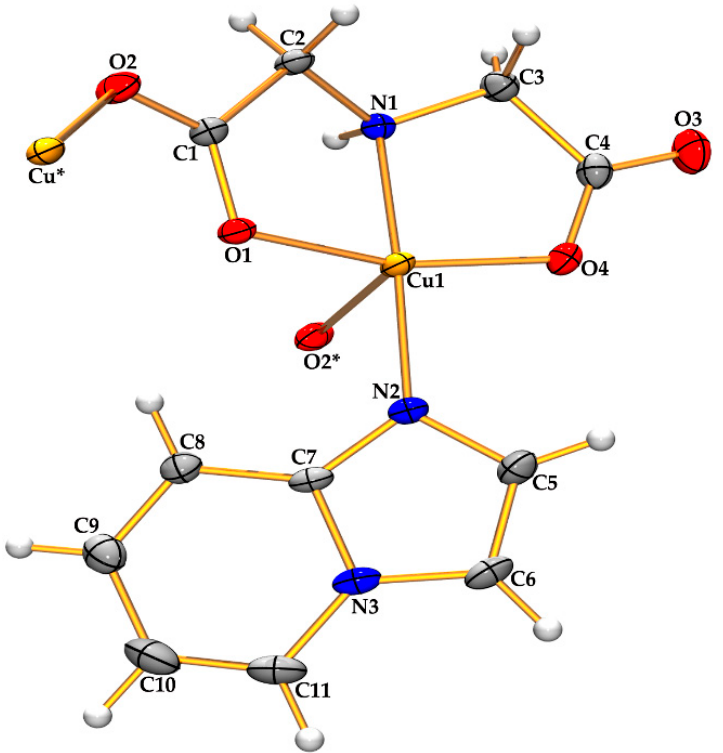
Figure 1. An ORTEP view (ellipsoids of thermal oscillations with 30% probabilities) with atom numbering scheme of compound ( 1 ). The atoms that are labelled with (*) are generated through symmetry operation (2 − x, 1/2 + y, 1 − z).